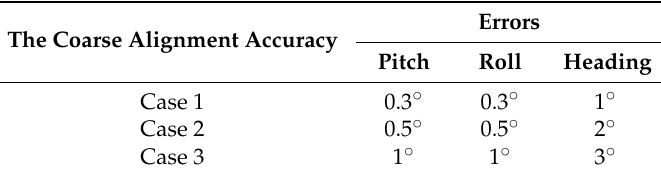
Table 5. The different initial conditions for fine alignment.